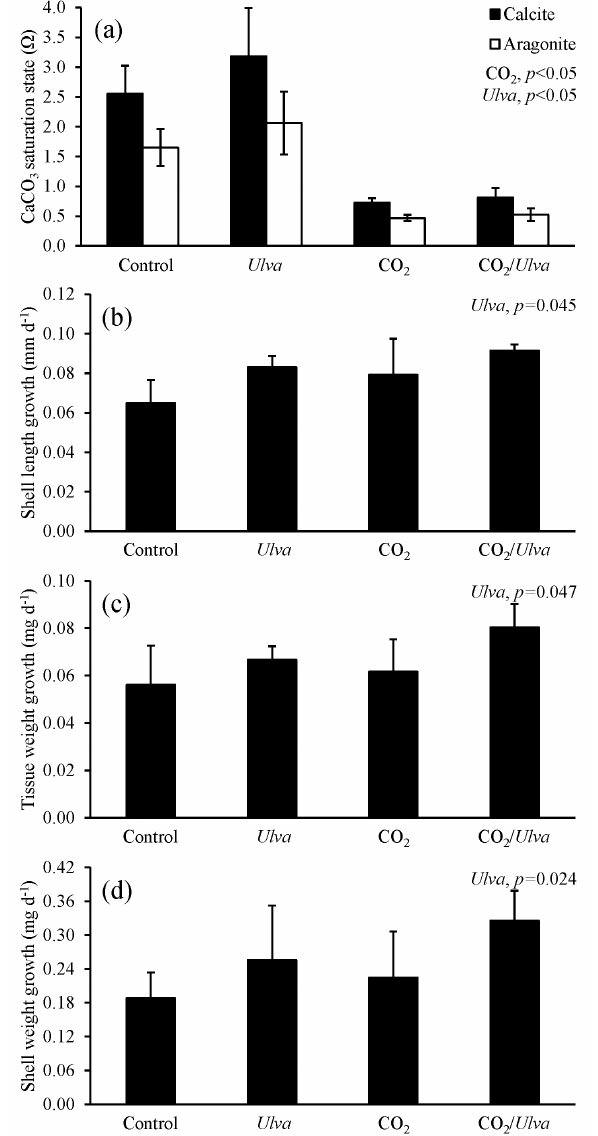
Figure 6. Experiment with large Argopecten irradians exposed to ambient and elevated concentrations of CO 2 with and without the presence of Ulva . (a) (cid:127) calcite and (cid:127) aragonite ; growth was based on (b) shell length, (c) tissue weight, and (d) shell weight. Columns represent means ± standard deviation. Significant main treatment ef- fects (CO 2 and Ulva ) appear at the top right of each panel.